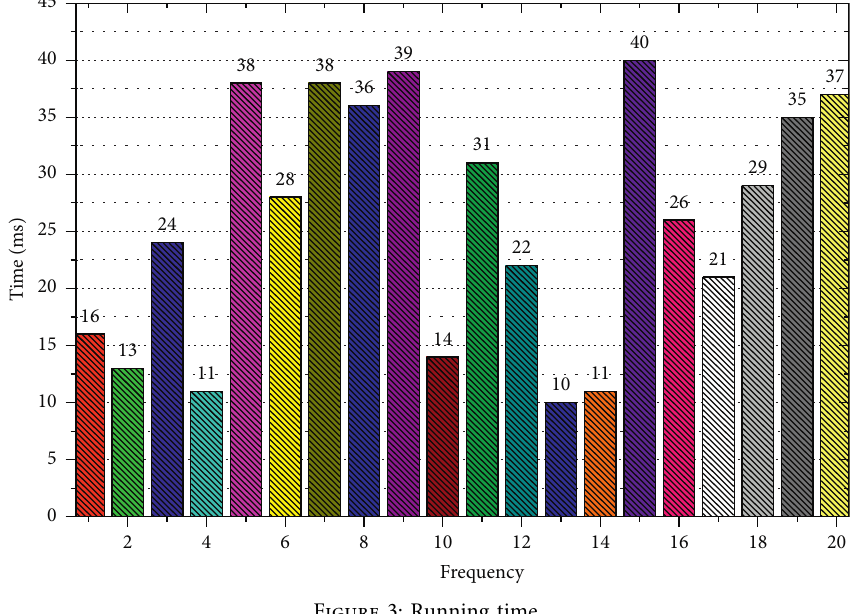
Figure 3: Running